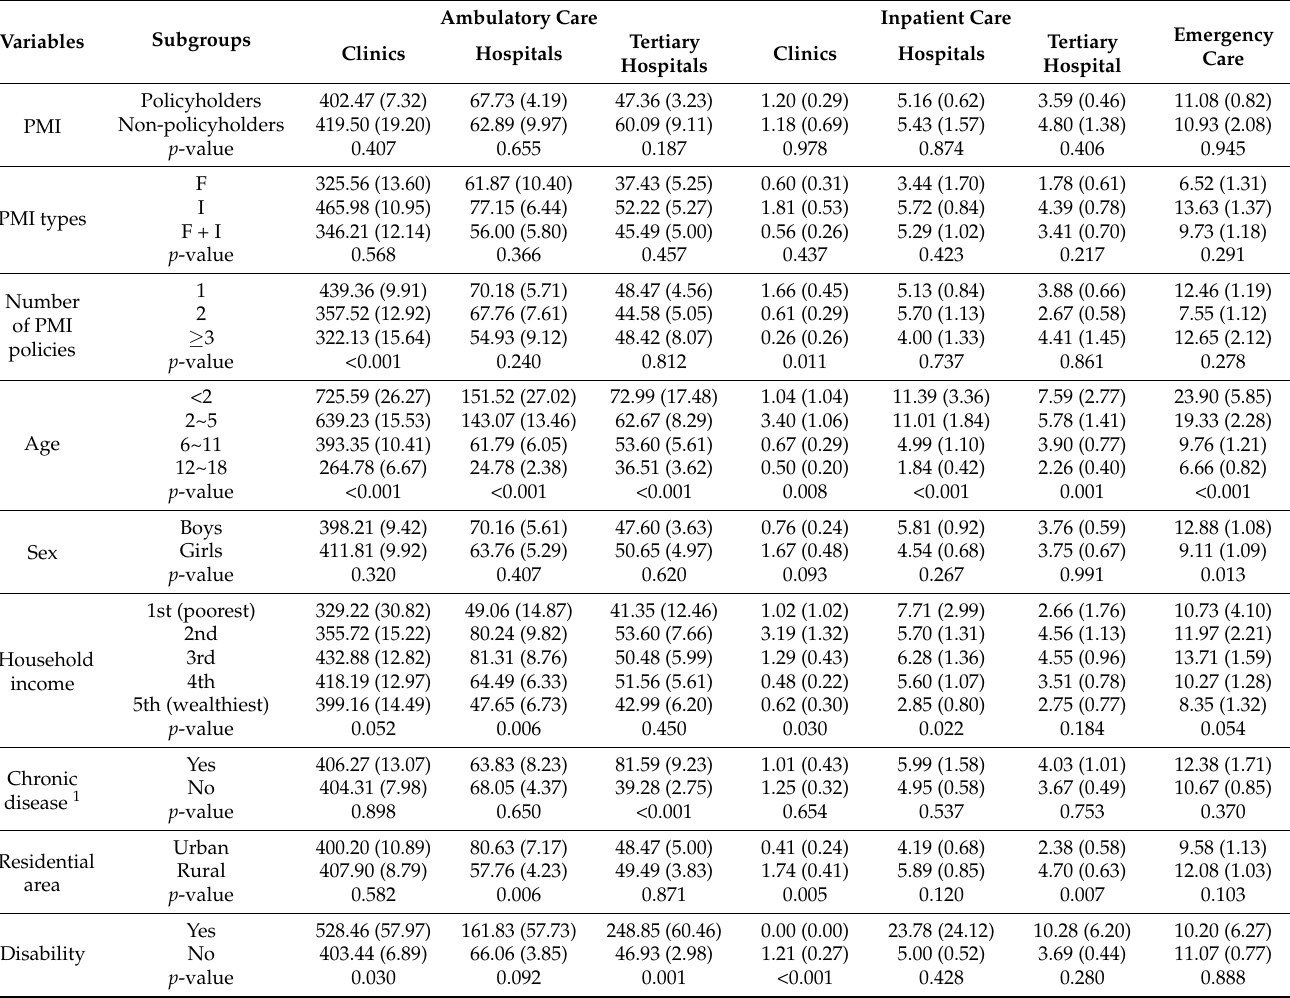
Table 2. Estimated number of children and adolescents per 1000 people aged 18 and younger participating in health care by private medical insurance status and sociodemographic